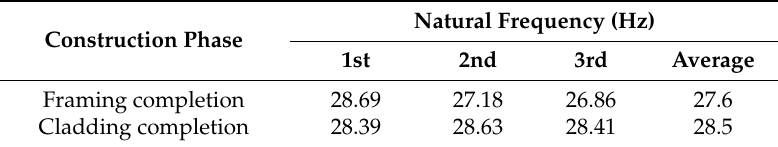
Table 4. Natural frequencies for di ff erent construction phases.